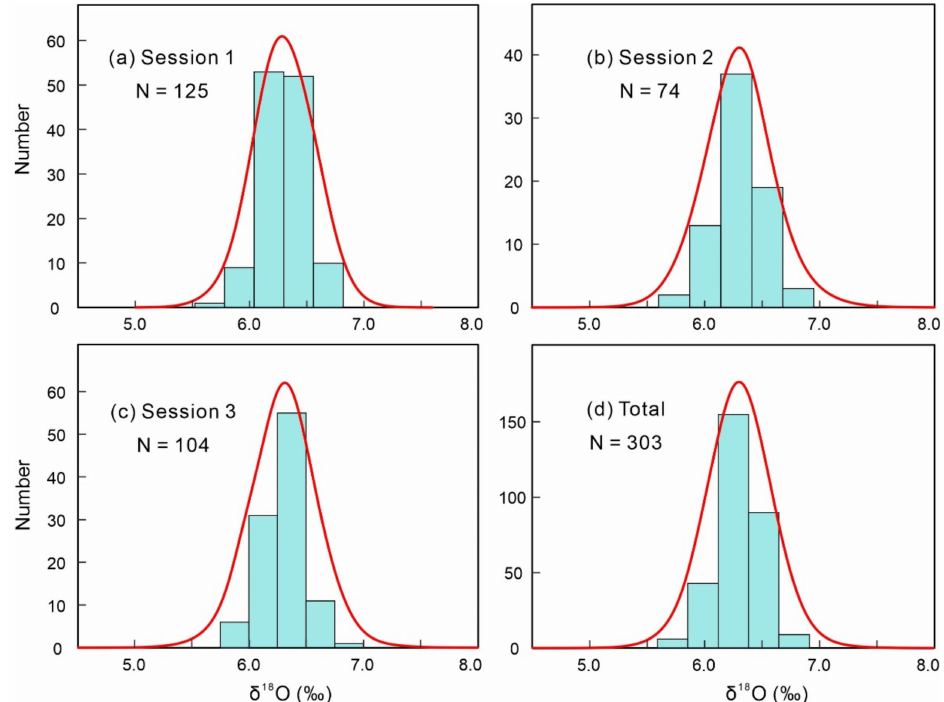
Figure 5. ( a – d ) Frequency distributions of RW-1 secondary ion mass spectrometry (SIMS) δ 18 O values with the average measured δ 18 O value normalized to the laser fluorination isotope ratio mass spectrometry (LF-IRMS)